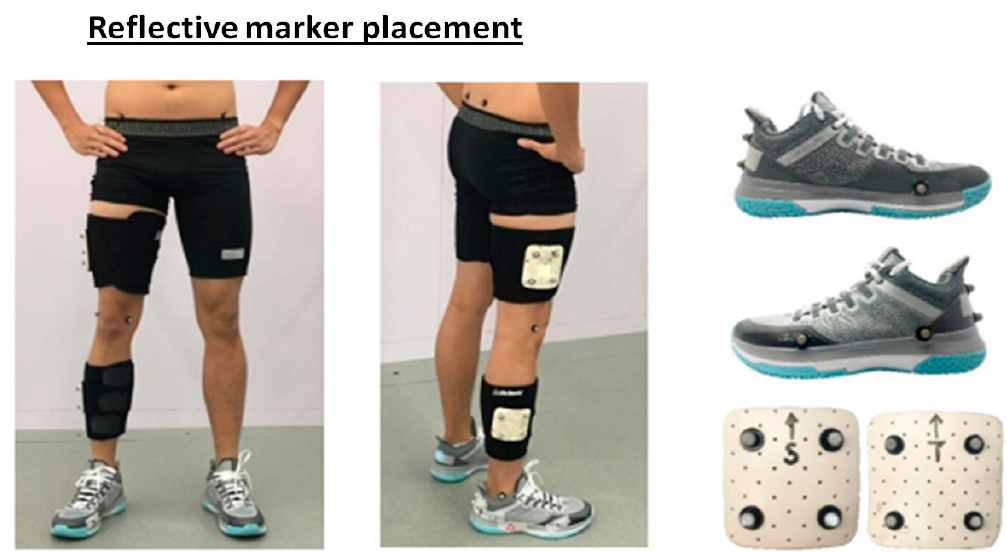
Figure 2. Reflective marker placements